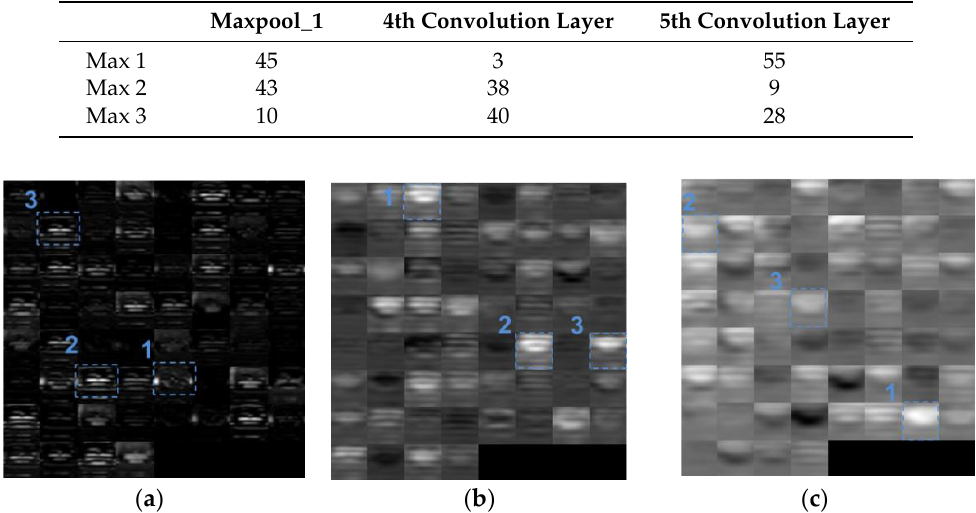
Figure 11. Feature sets used in the experiment.